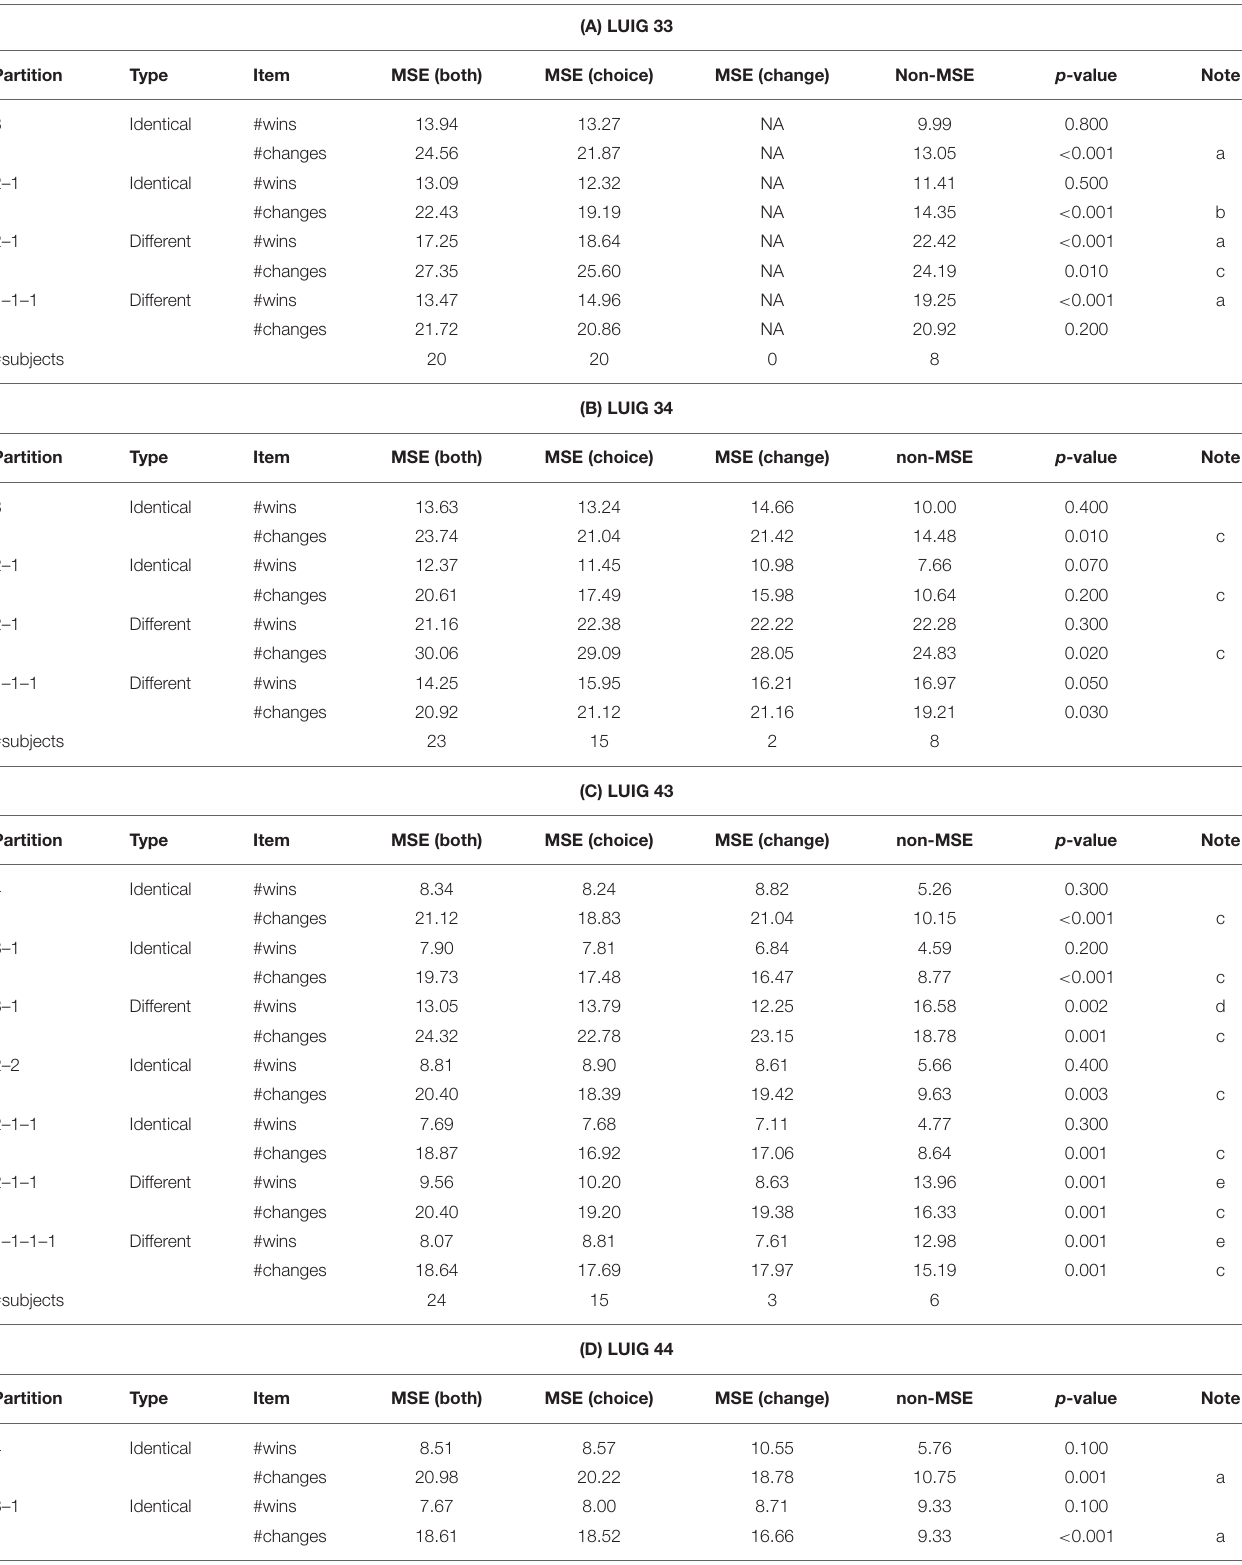
TABLE 5 | Differences between types of subjects with respect to the numbers of wins and changes in computational round robin